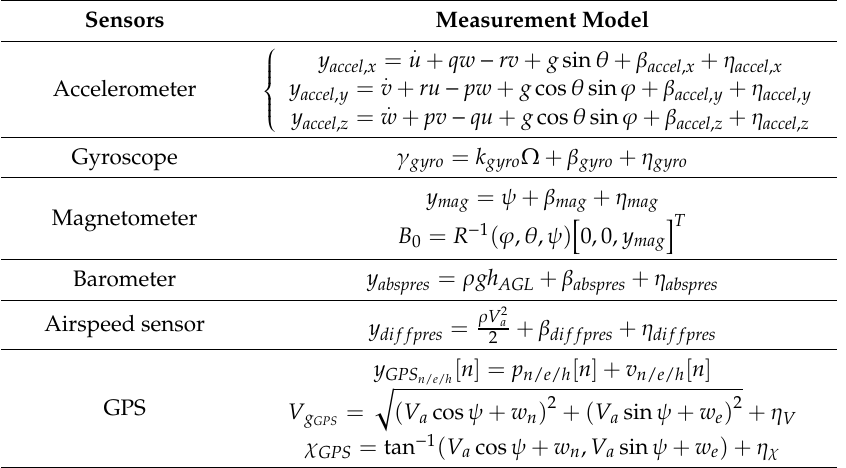
Table 4. Measurement model of di ff erent